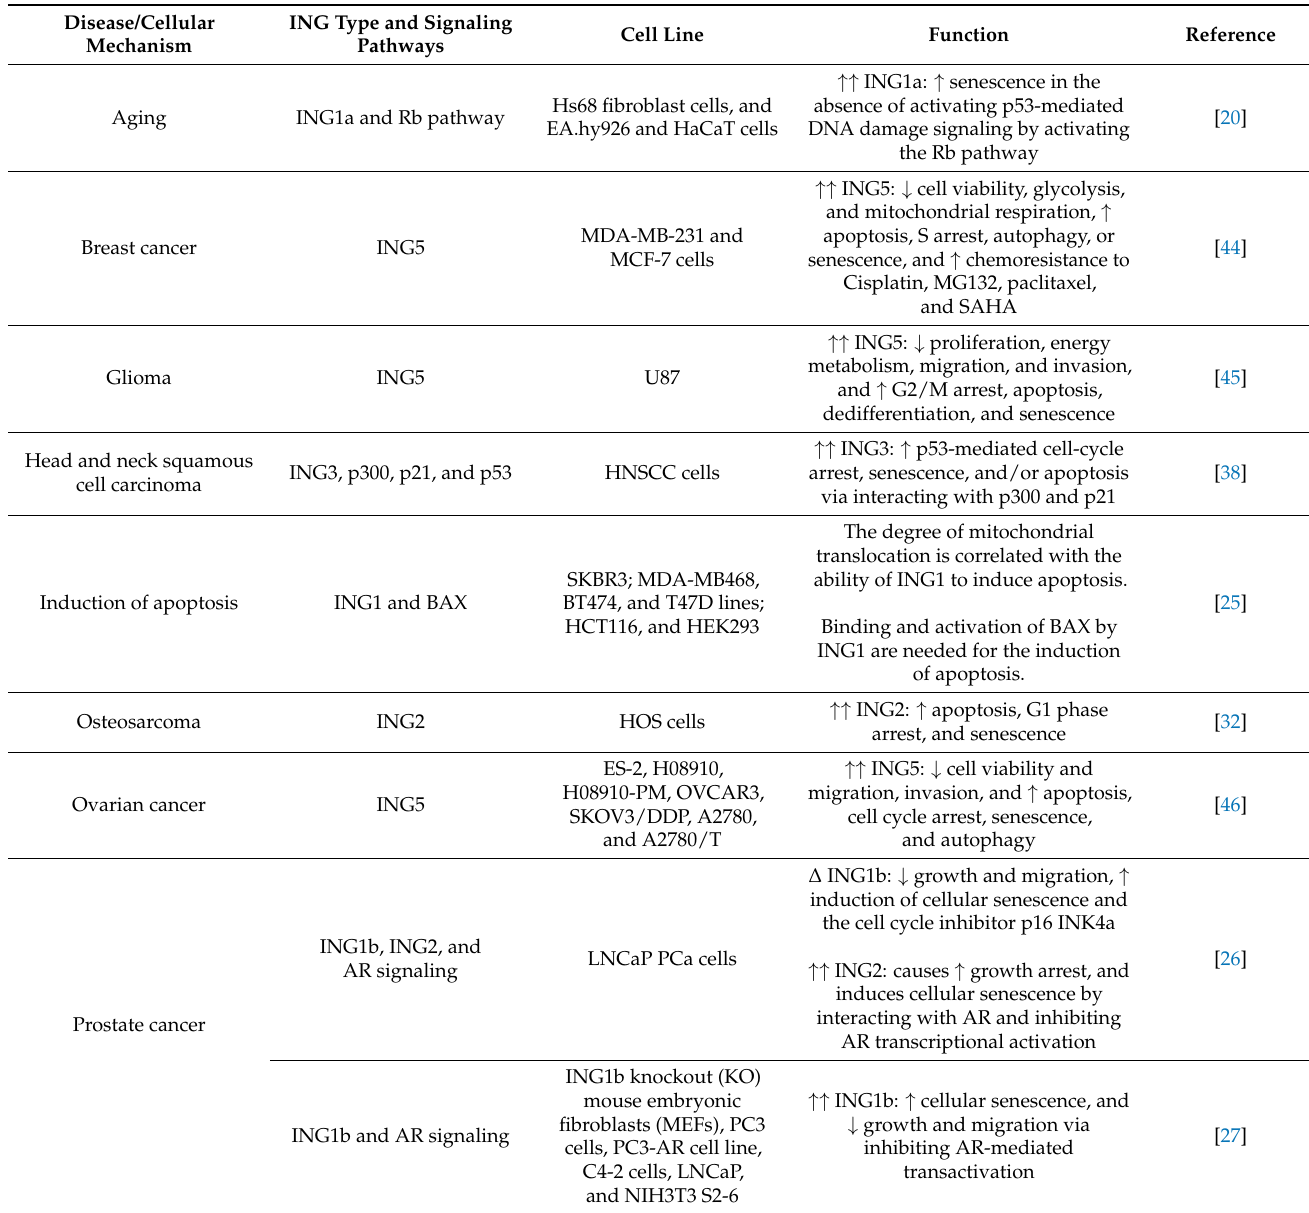
Table 2. Impact of INGs on cellular senescence based on cell line